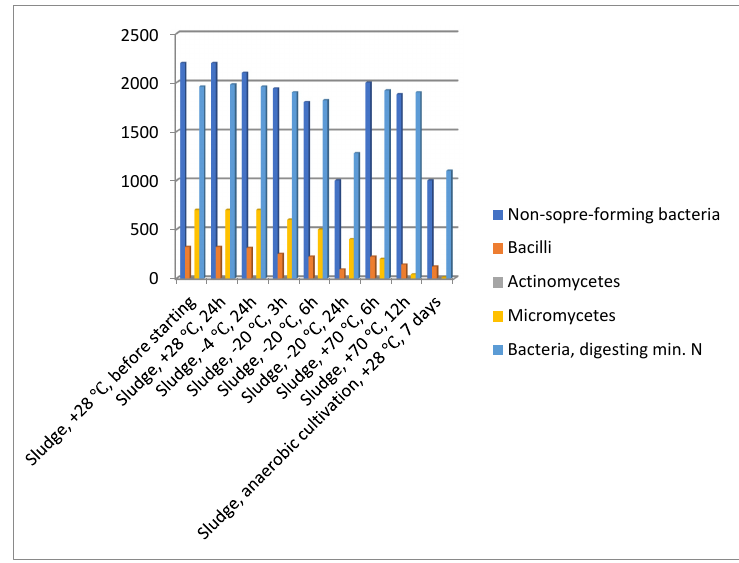
Figure 2. Non-pathogenic microflora (cfu/g).